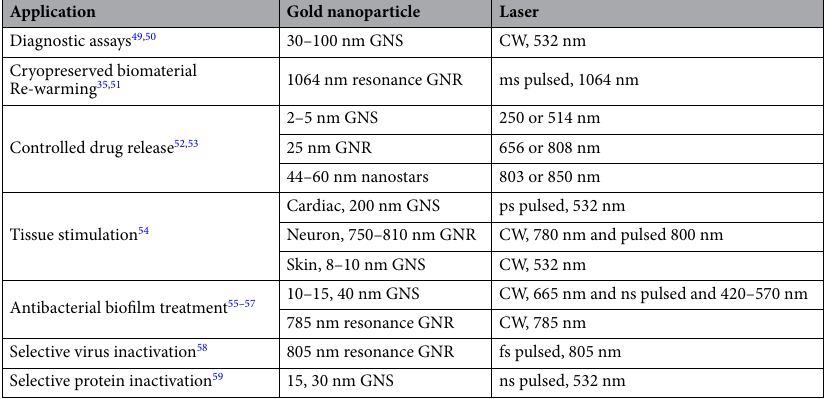
Table 1. Emerging biomedical applications of laser GNS